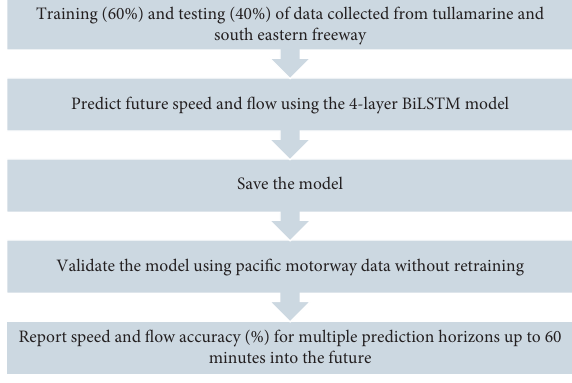
Figure 10: Validation experiment design. Table 6: Speed and flow validation results for different prediction horizons.